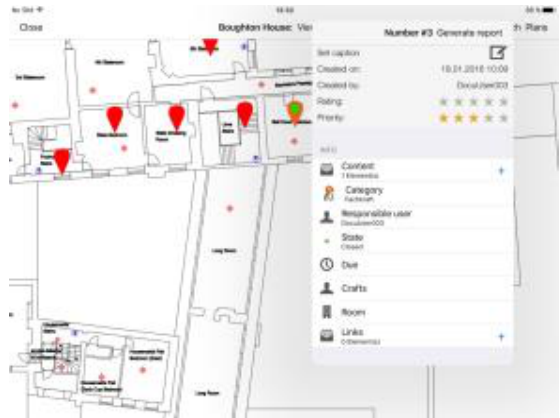
Figure 2 Screenshot of docu-tools. Boughton House